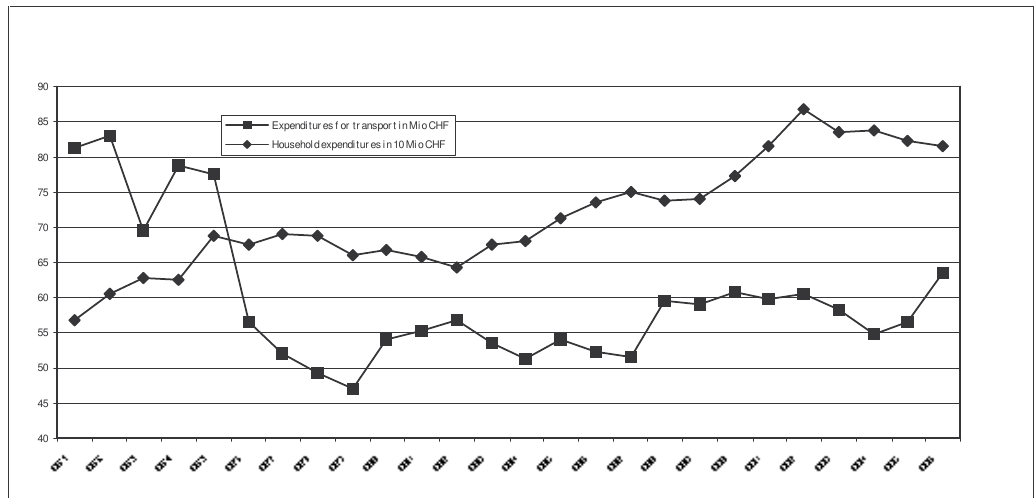
Figure 4. Expenditure on transport: City of Bielefeld and Stadtwerke Bielefeld 1973-96 (prices from 1985) Sources: Haefeli 1998 .